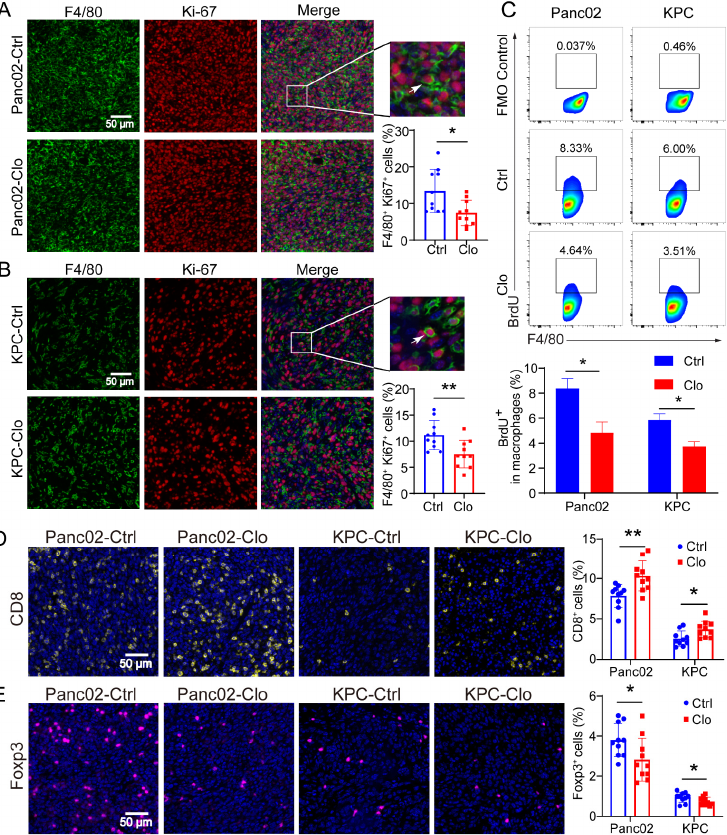
Figure 4. Proliferating F4/80 + macrophages were reduced in Panc02 and KPC mouse models after clodronate liposomes treatment. ( A , B ) Representative immunofluorescence images of Ki ‐ 67 and F4/80 staining in Panc02 or KPC tumors and quantitation of Ki ‐ 67 and F4/80 immunofluorescence staining. ( C ) Analysis of BrdU + macrophages in Panc02 and KPC tumor tissues. The animals were injected with BrdU at 12 h and 24 h before sacrifice. ( D , E ) Staining of CD8 + T and Foxp3 + T cells in Panc02 or KPC tumors with or without clodronate liposomes treatment. Data are shown as the mean ± SEM. Statistical analyses were carried out by Student’s t test. *: p ≤ 0.05, **: p ≤